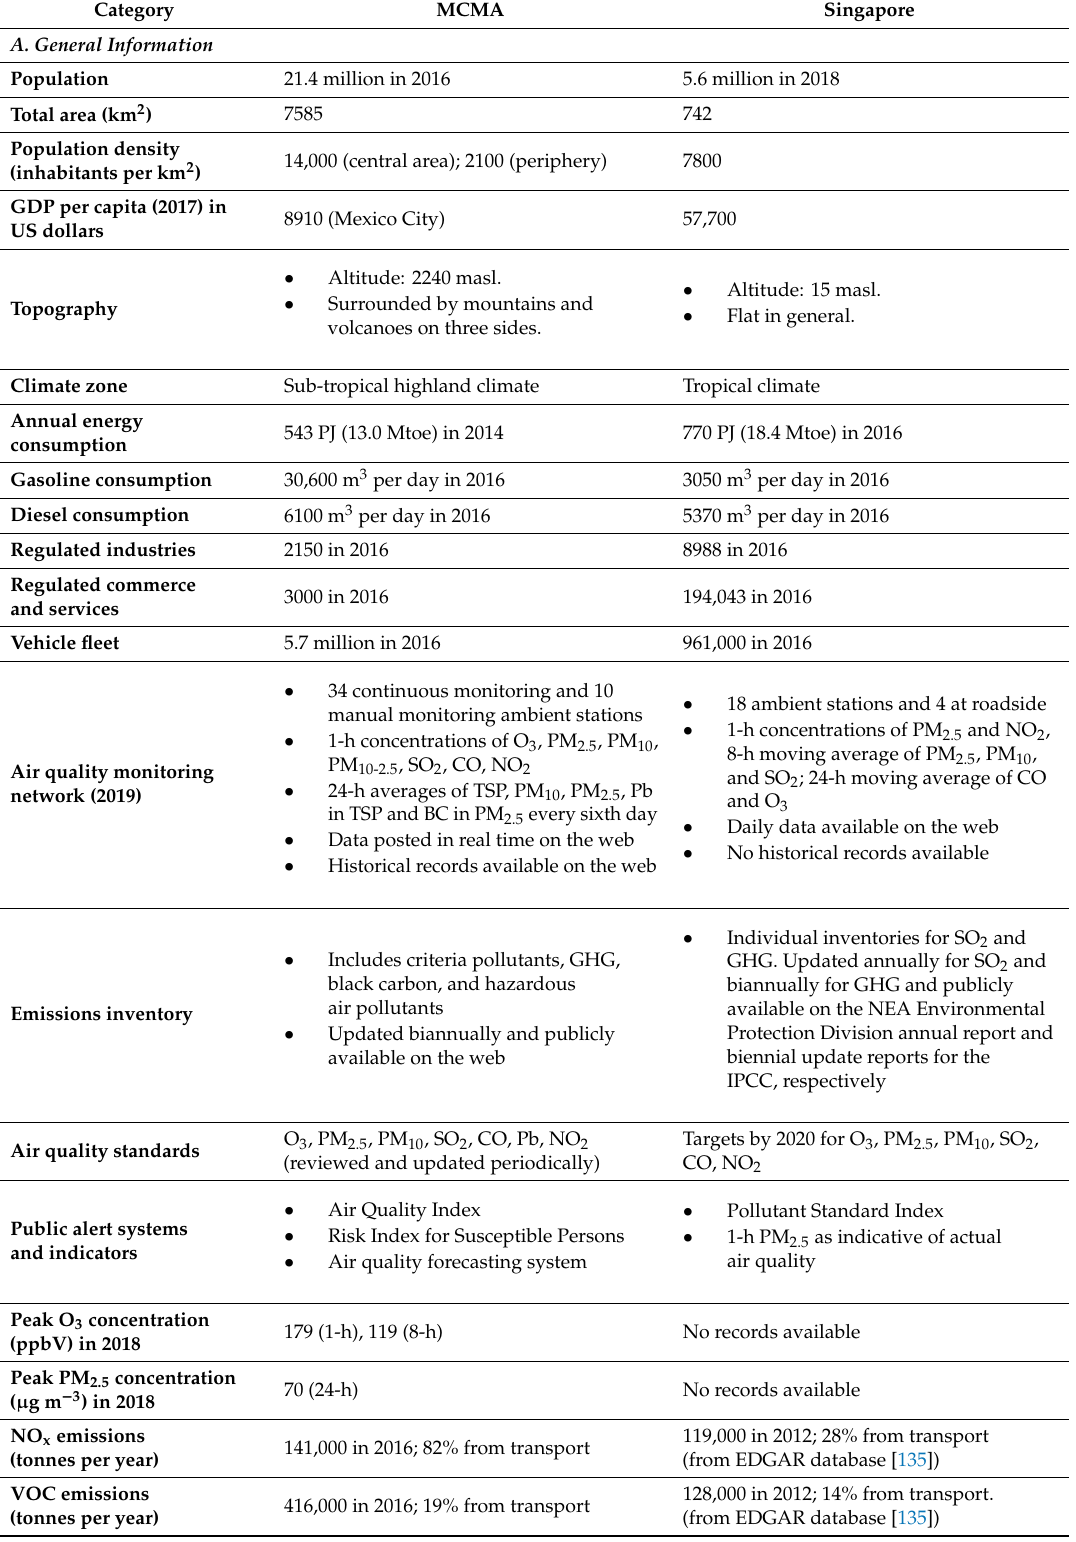
Table 3. Comparison of selected statistics and air quality management programs between the MCMA and